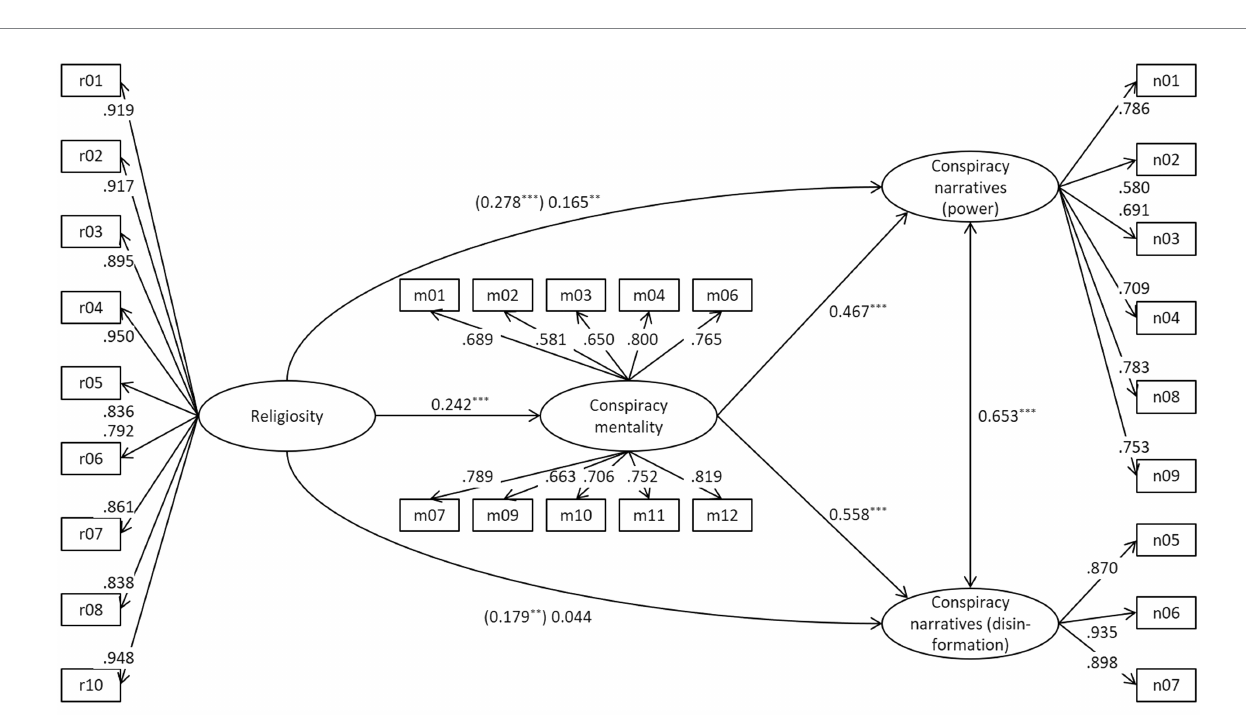
FIGURE 2 Prediction of conspiracy narratives: two factors (standardised coefficients). For all factor loadings p < 0.001. ** p < 0.01 *** p < 0.001. Indirect effect (power) = 0.113, p < 0.001; indirect effect (disinformation) = 0.135, p <